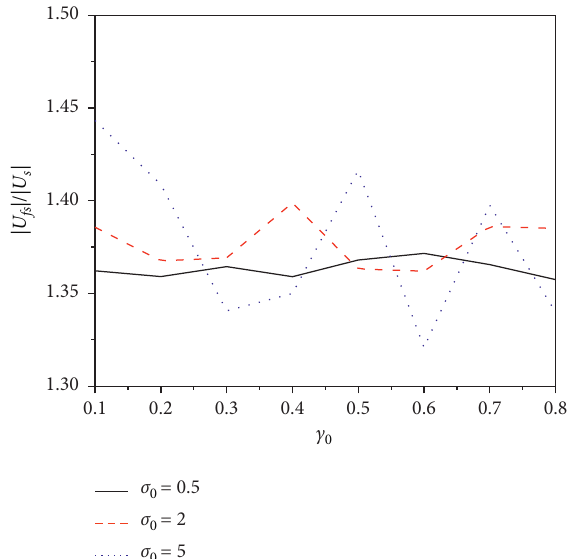
Figure 26: The variation in the ratio | U for different values of σ